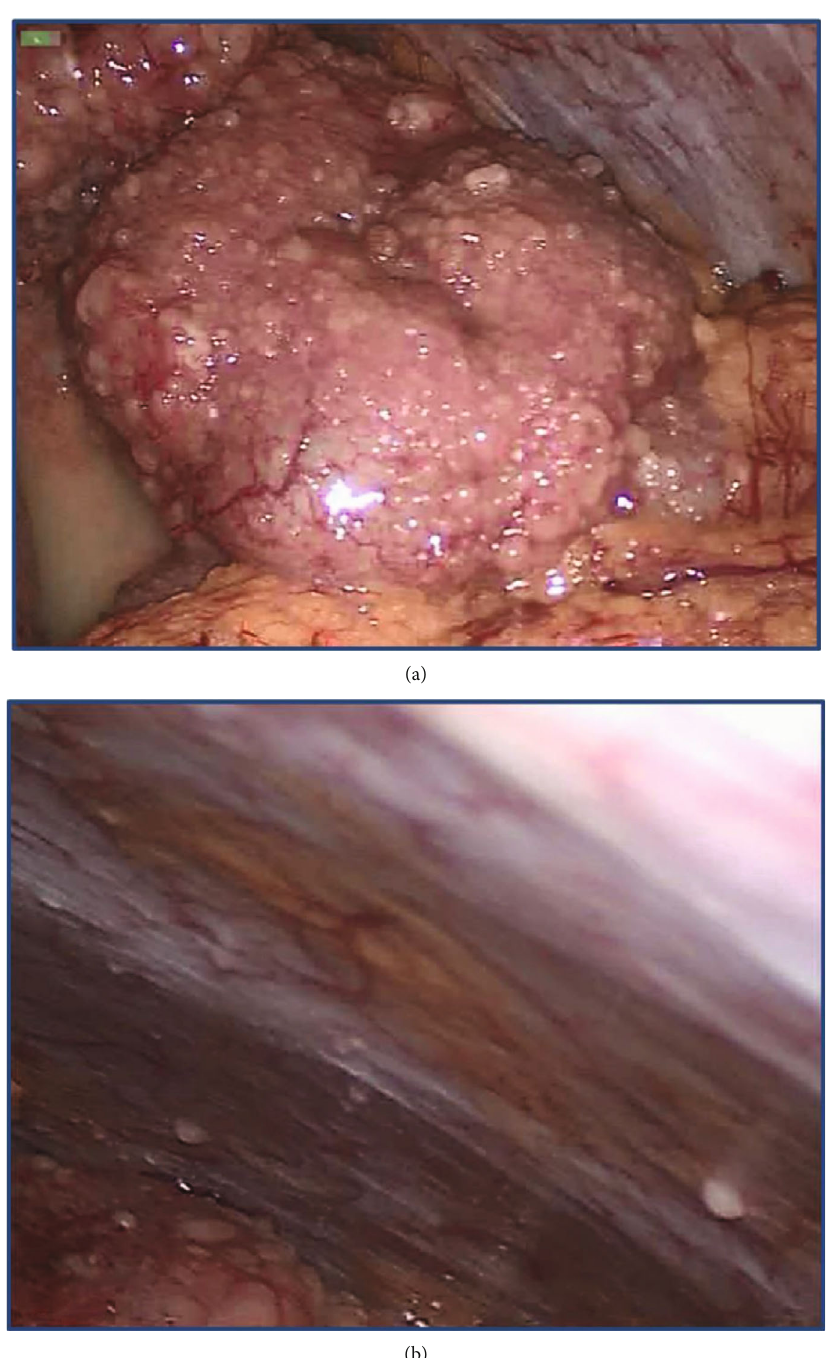
Figure 1: (a) A diagnostic laparoscopy demonstrates numerous ectopic decidual nodules covering the small bowel and imitating peritoneal carcinomatosis. There is a moderate amount of purulent-appearing fl uid in the pelvis. (b) A diagnostic laparoscopy shows 3-5 mm nodules of ectopic deciduosis on the abdomen wall